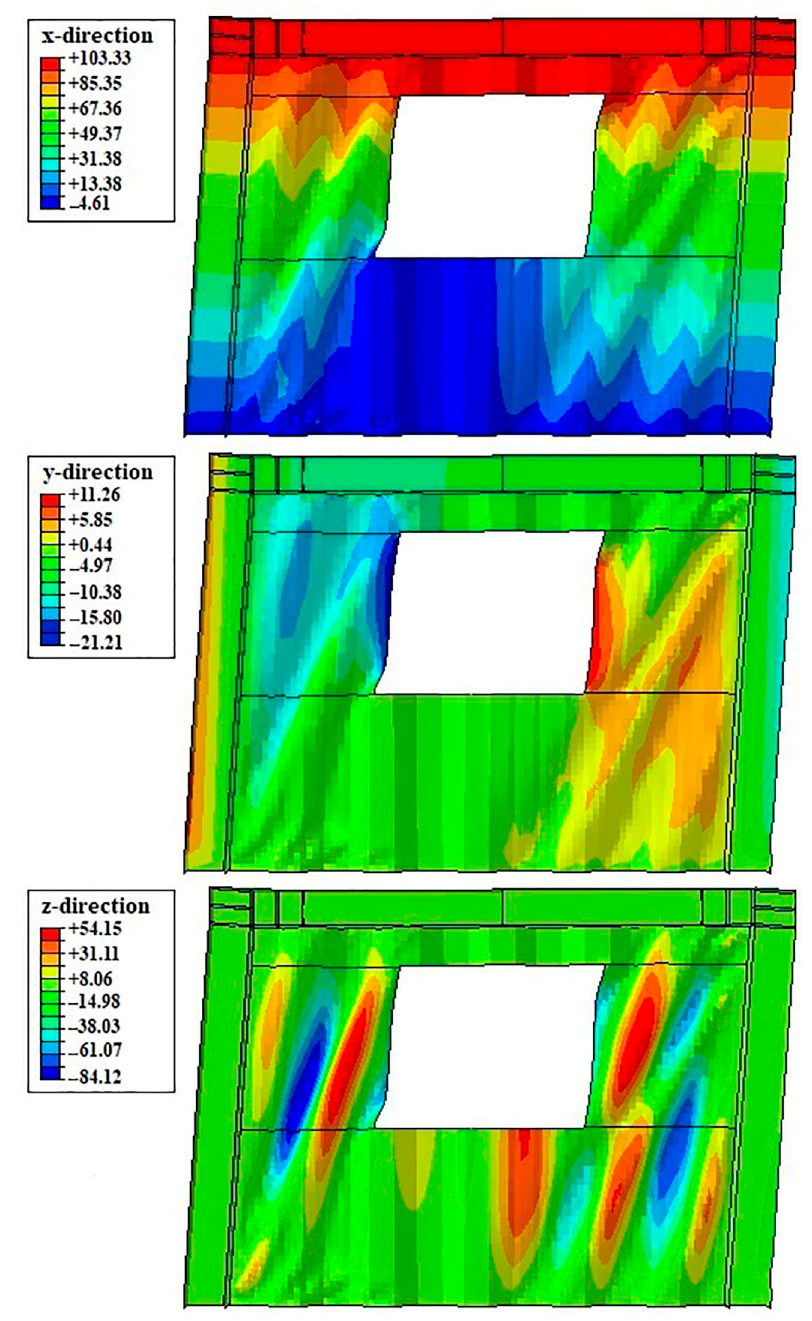
Figure 22. Final deformation form of specimen 1 (mm).